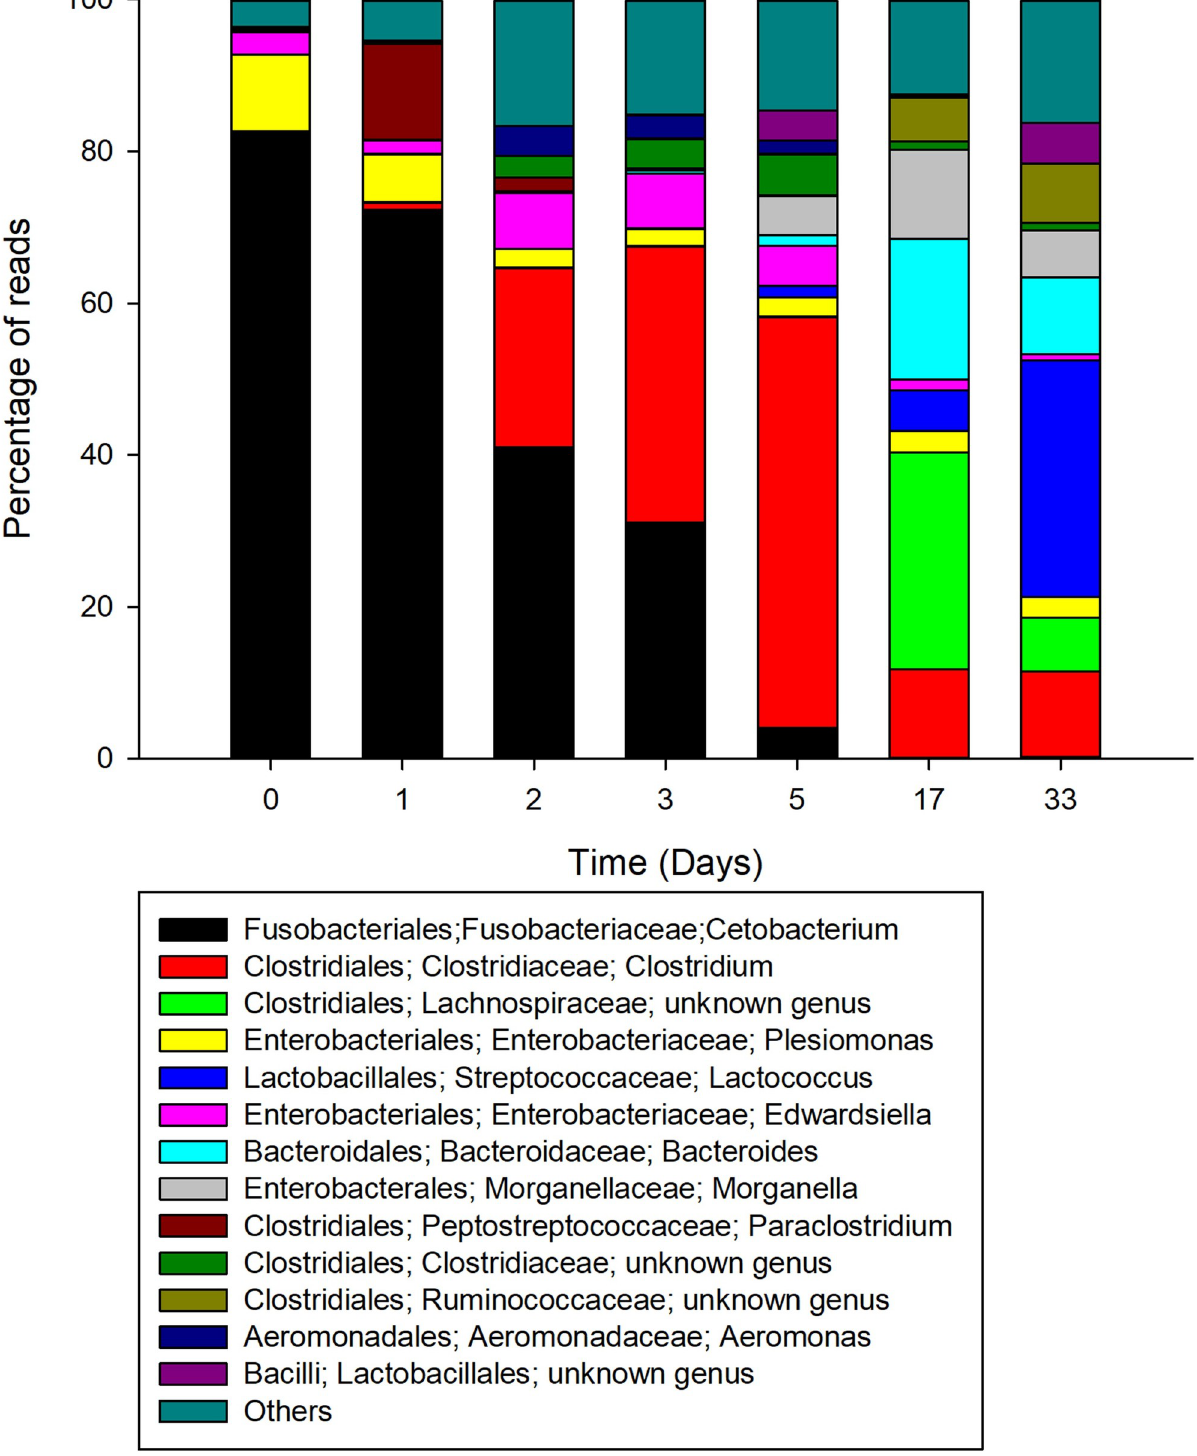
Fig 5. Relative abundance of intestinal bacteria genera in a Nile tilapia ( Oreochromis niloticus )-derived continuous-flow competitive exclusion culture.